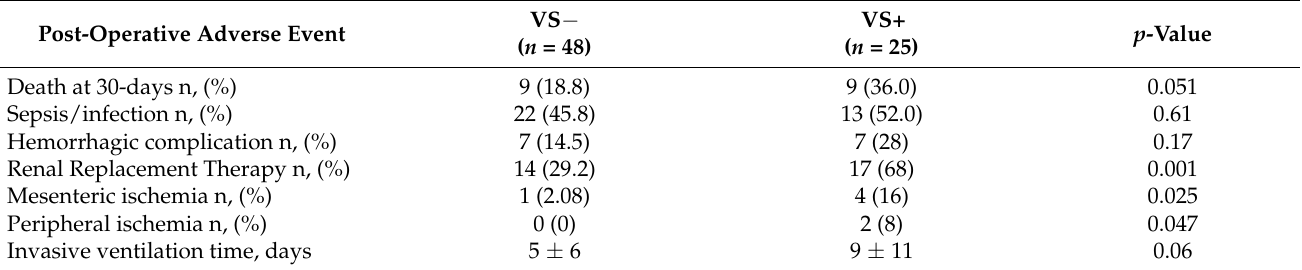
Table 3. Postoperative adverse events according to the presence of